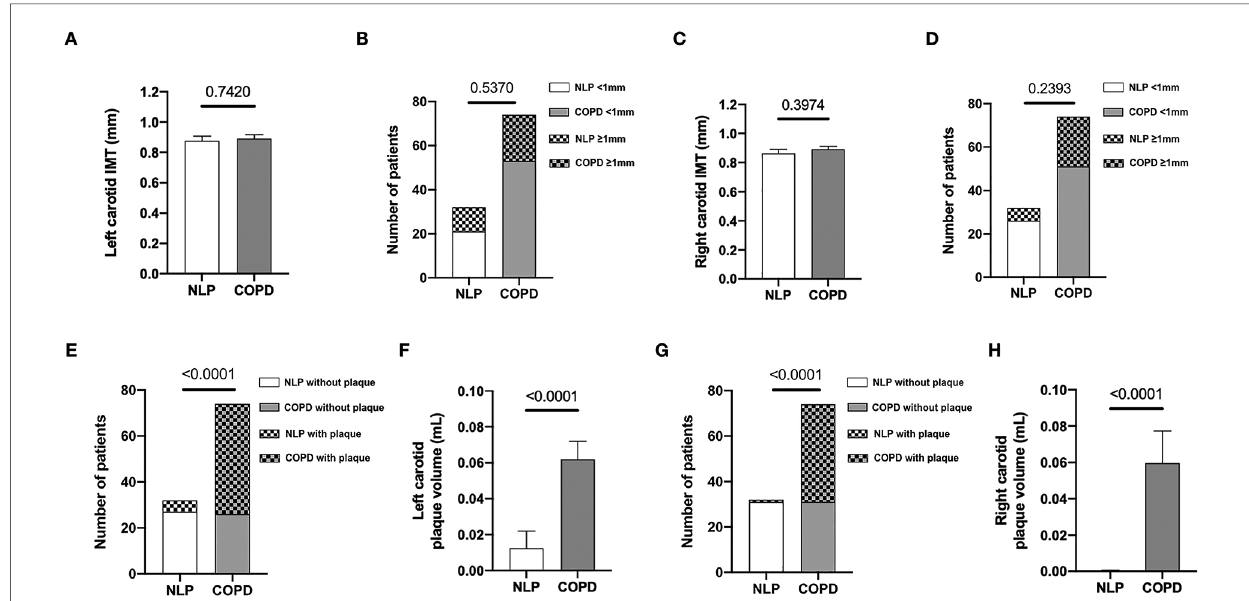
FIGURE 1 Prevalence of carotid atherosclerosis in the study population. Number of COPD patients and NLP subjects with left and right carotid IMT measurements (panels A and C, respectively) and differences between the study groups regarding mean IMT of left and right carotids (panels B and D, respectively). Number of COPD patients and NLP subjects with left and right carotid plaque measurements (panels E and G, respectively) and differences between the study groups regarding mean volume of left and right carotid plaques (panels F and H, respectively). COPD, chronic obstructive pulmonary disease, n =74. NLP, normal lung parameters, n =32.